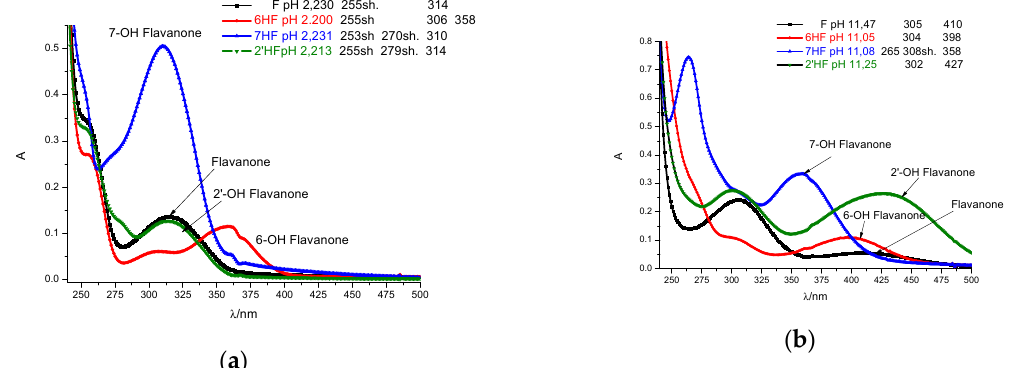
Figure 2. Comparison of absorption spectra of F, 6HF, 7HF and 2’HF in acidic ( a ) and alkaline ( b ) ranges. (Origin(Pro) software using the original files from the instrument: Perkin-Elmer Lambda 11 spectrophotometer).